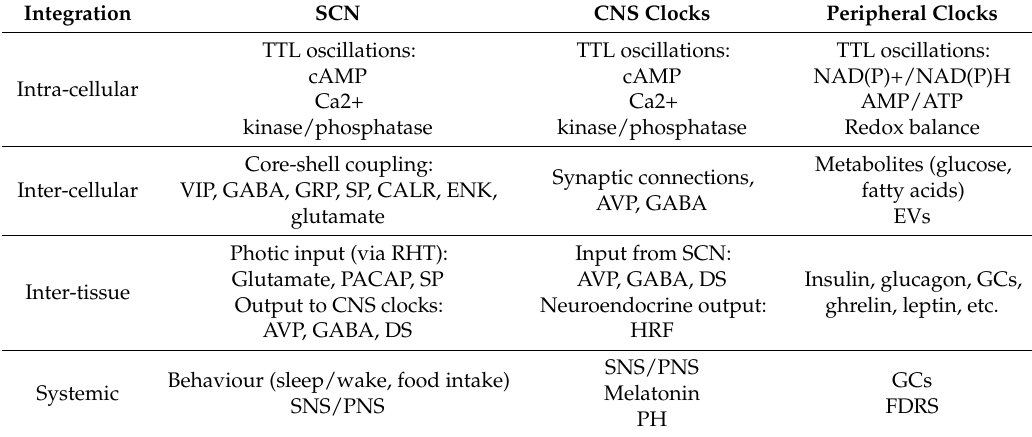
Table 1. Pathways and signals involved in clock-to-clock